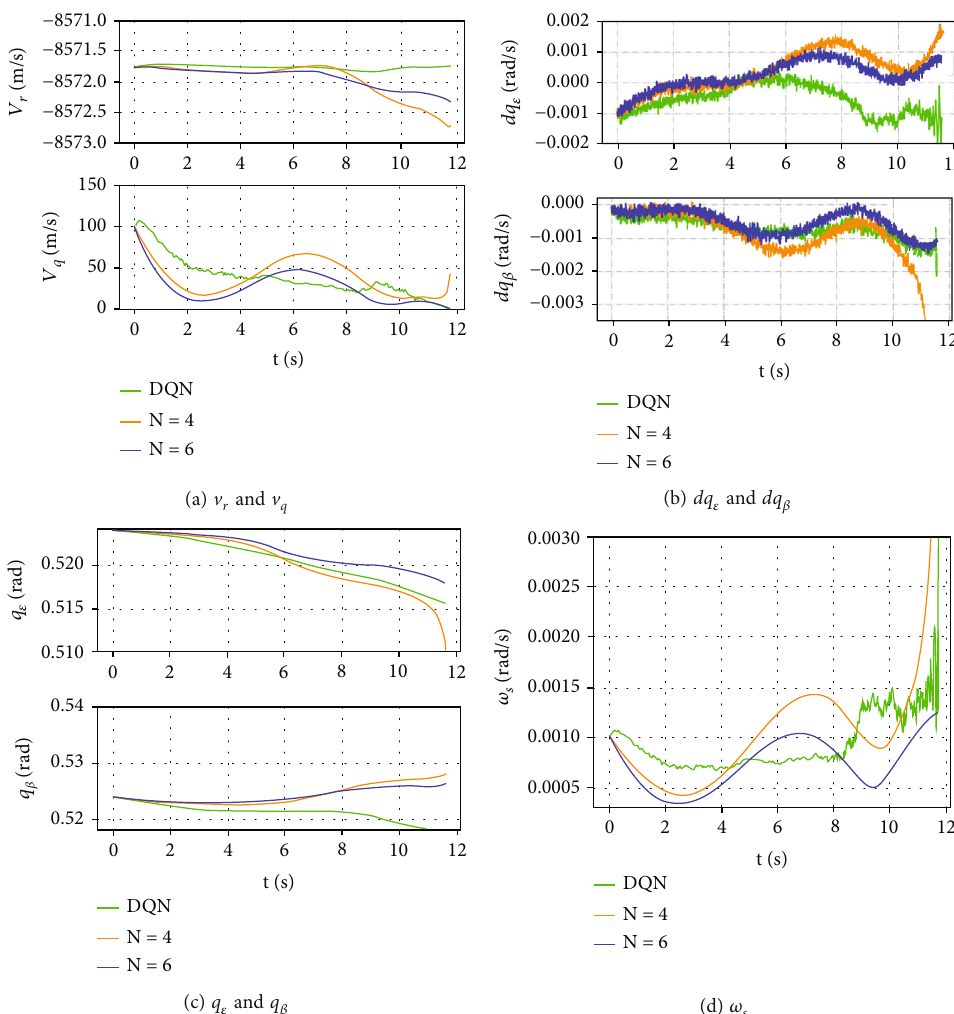
Figure 12: DQN simulation results of sinusoidal maneuvering